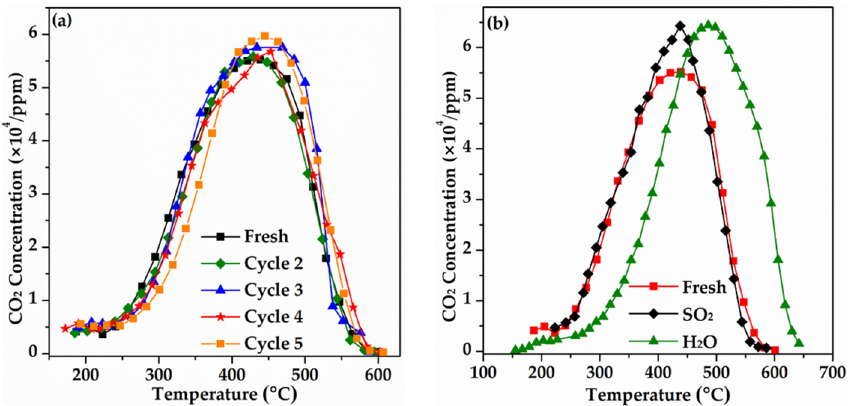
Figure 2. The CO 2 concentration curves of cycle test ( a ) and resistance versus sulfur and water ( b ) over Mn 0.7 K 0.3 Co 2 O 4 -HC monolith catalyst. ( b ) over Mn 0.7 K 0.3 Co 2 O 4 -HC monolith